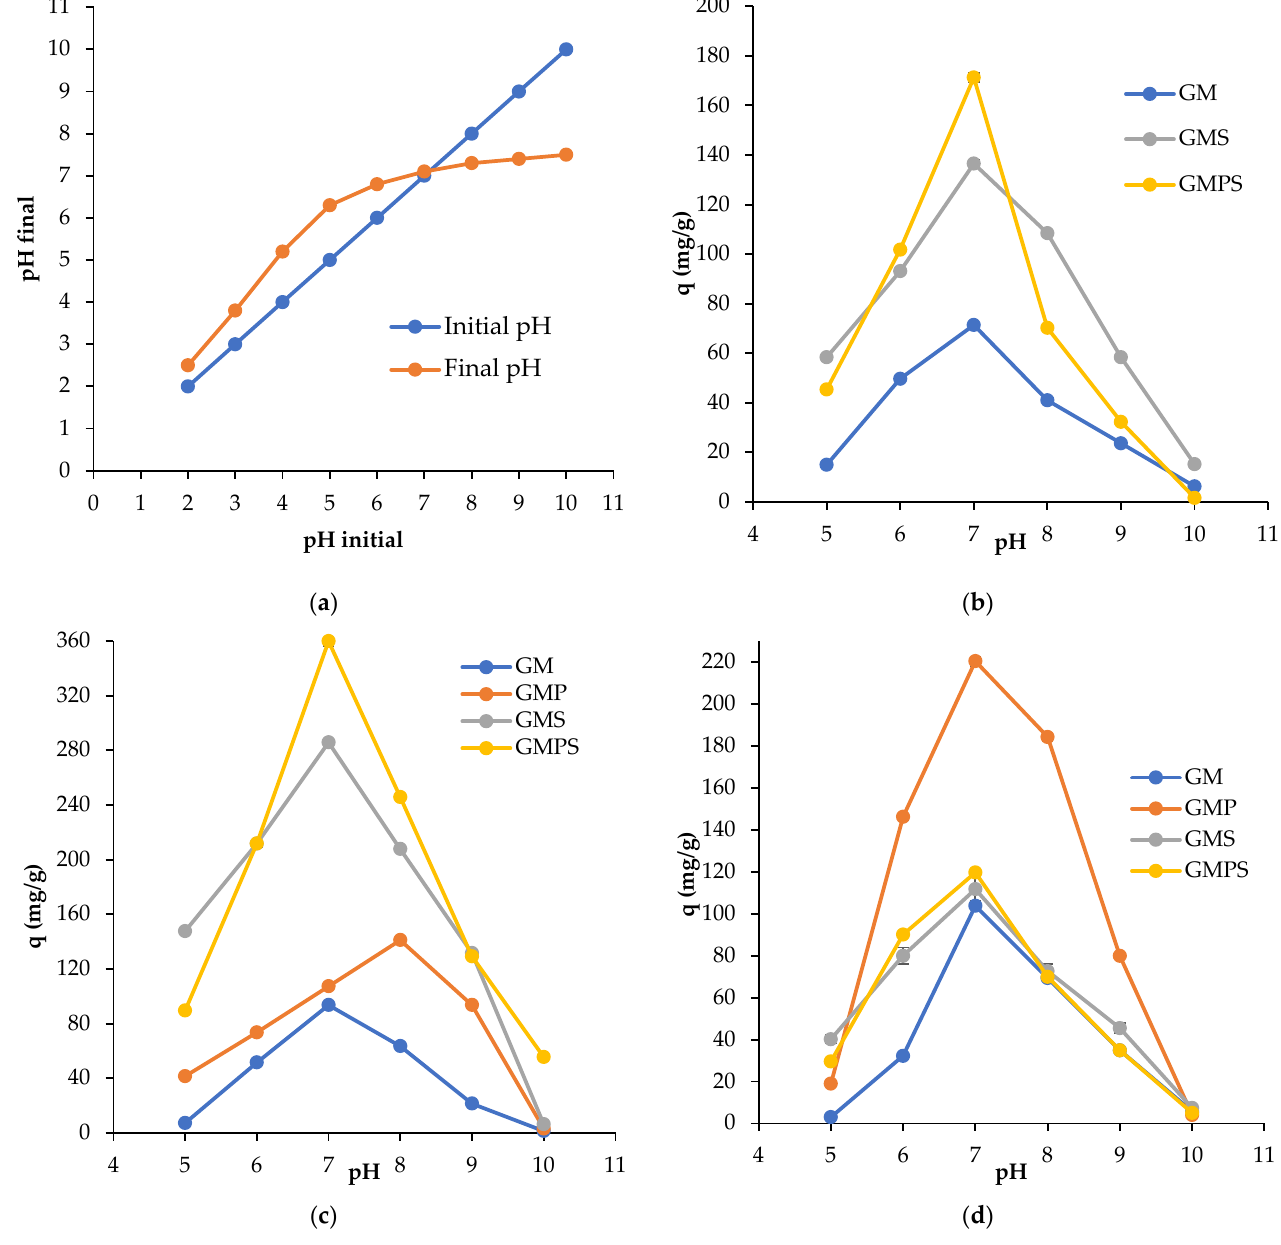
Figure 3. Effect of solution pH on adsorption capacity ( a ) pH initial vs. pH final graph for pHpzc calculation, ( b ) Foron black dye, ( c ) Foron blue dye, and ( d ) Foron red dye.